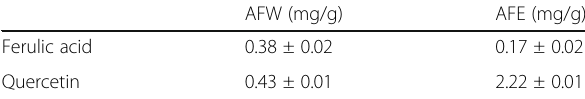
Table 2 Content of components in the A. fistulosum extracts